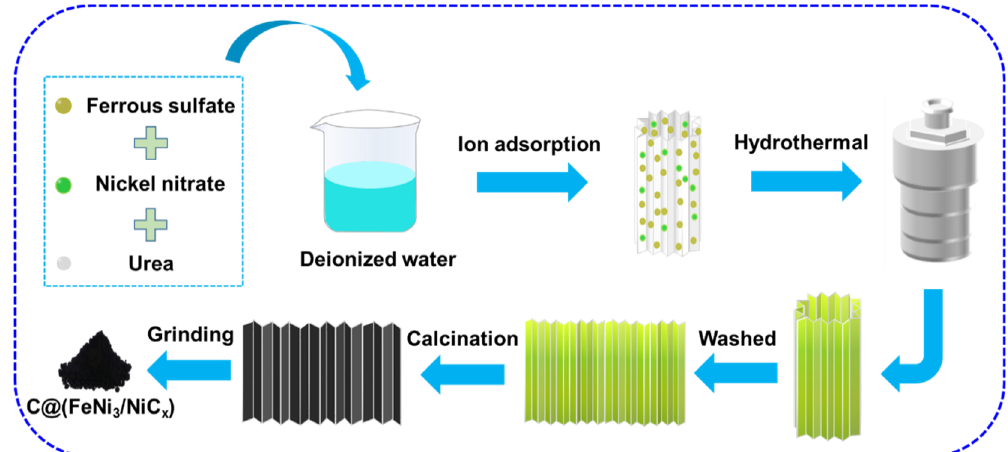
Figure 1. Synthetic route of C@(FeNi 3 /NiC x ) composites.